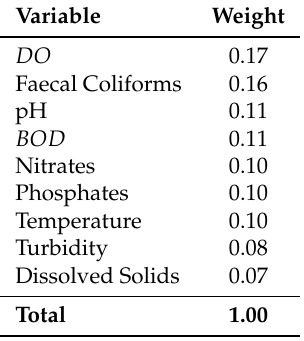
Table A1. Weights for variables included in National Sanitation Foundation Water Quality Index